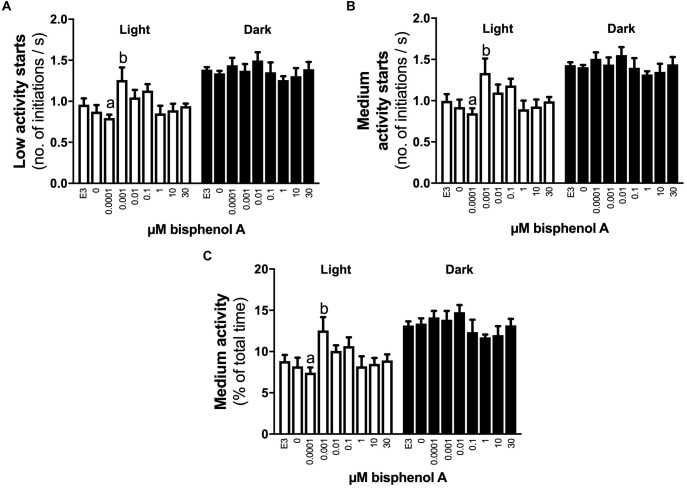
The effects of early developmental exposure to BPA on zebrafish embryo locomotor activity at 5 dpf. The amount of time (% of total) that 5 dpf zebrafish larvae initiated low (A) or medium (B) levels of activity, and the time medium levels of activity were undertaken (C), under either light (open bars) or dark (black bars) after aqueous exposure to graded levels of BPA (0–30 μM) between 2 and 26 hpf. Letters indicates statistical differences in mean values between treatments (one-way ANOVA, Tukey post hoc test, p < 0.05). Data are the mean ± SEM, n = 3, where each replicate is the average of 8–24 larvae.